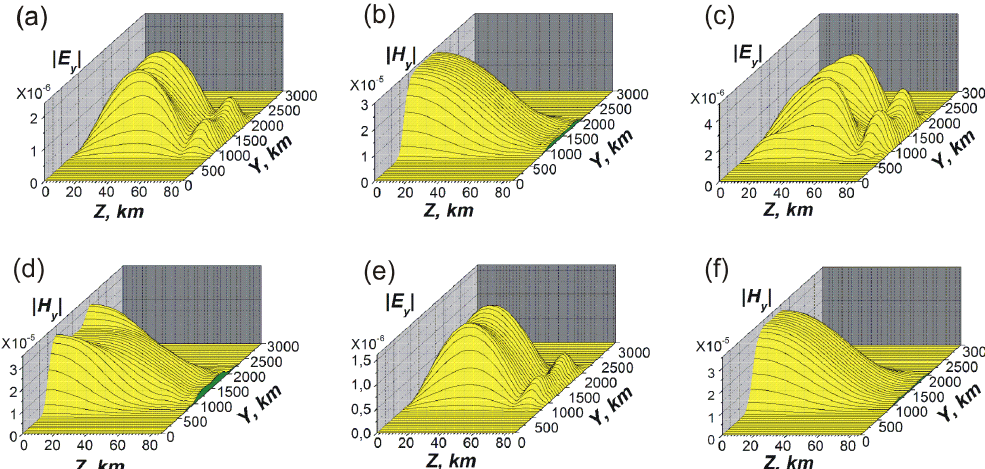
Figure 6. Panels (a) , (c) and (e) are dependencies of | E y | . Panels (b) , (d) and (f) are dependencies of | H y | at x = 1000km, with ω = 1 . 0 × 10 5 s − 1 and θ = 45 ◦ . The initial beams are the same as in Fig. 4a. Panels (a) and (b) correspond to the solid (1) curves in Fig. 5. Panels (c) and (d) are for the dashed (2) curves. Panels (e) and (f) correspond to the dotted (3) curves there.